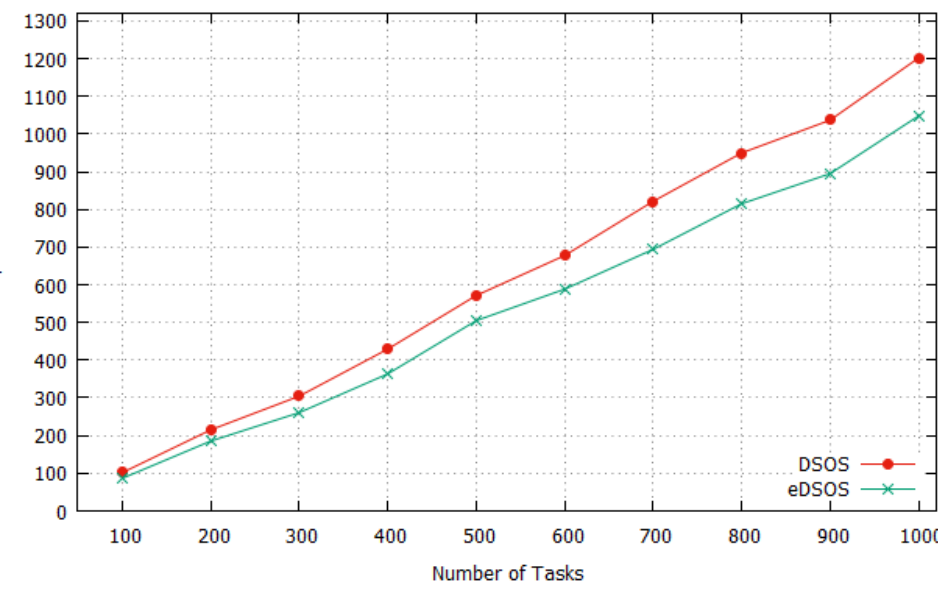
Figure 4. Makespan for the dataset with the left-half distribution.